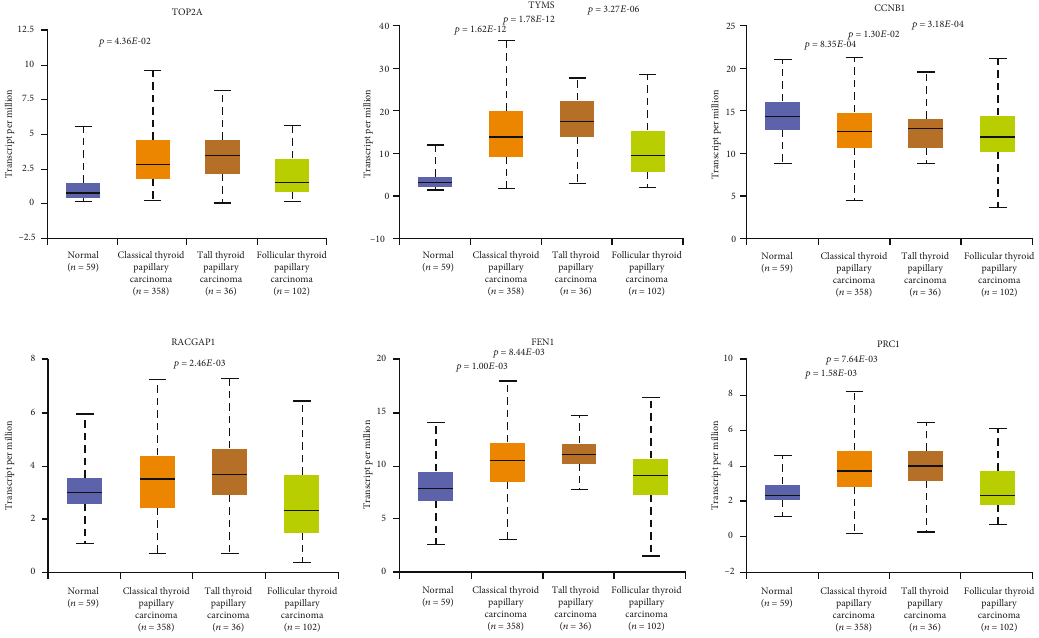
Figure 4: The expression levels of hub genes in other thyroid